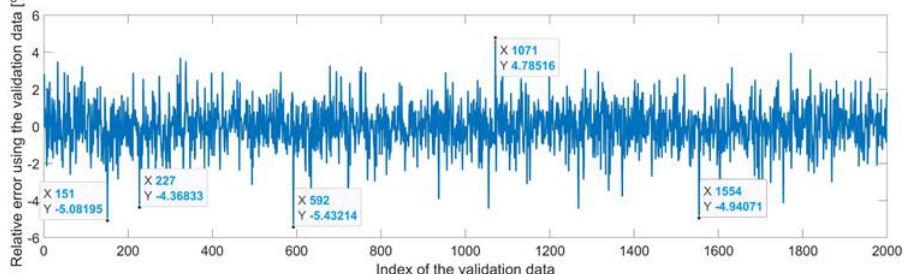
Figure 33. Relative errors between the target values and the predicted values for the workspace.